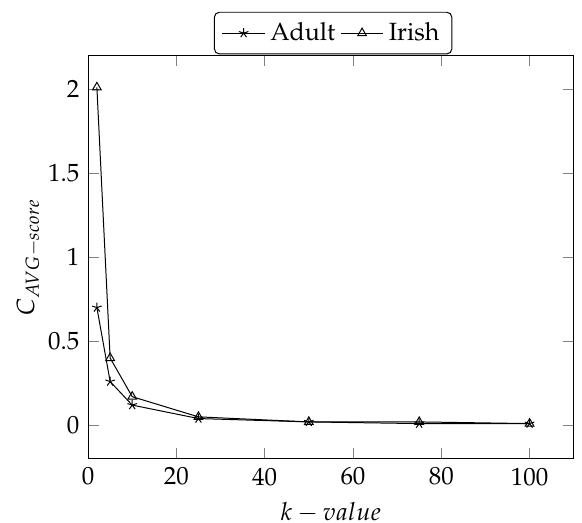
Figure 15. C AVG Performance of Utility.